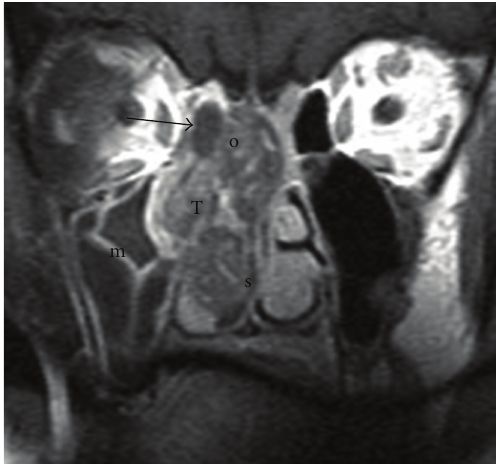
Figure 2: Initial lesion, MRI: MRI confirms CT scan images (T: Tumor, o: olfactory cleft, −→ : ethmoidal attic, and m: maxillary sinus). There is no typical signal of chordoma (T1 hyposignal and T2 very intense hypersignal).